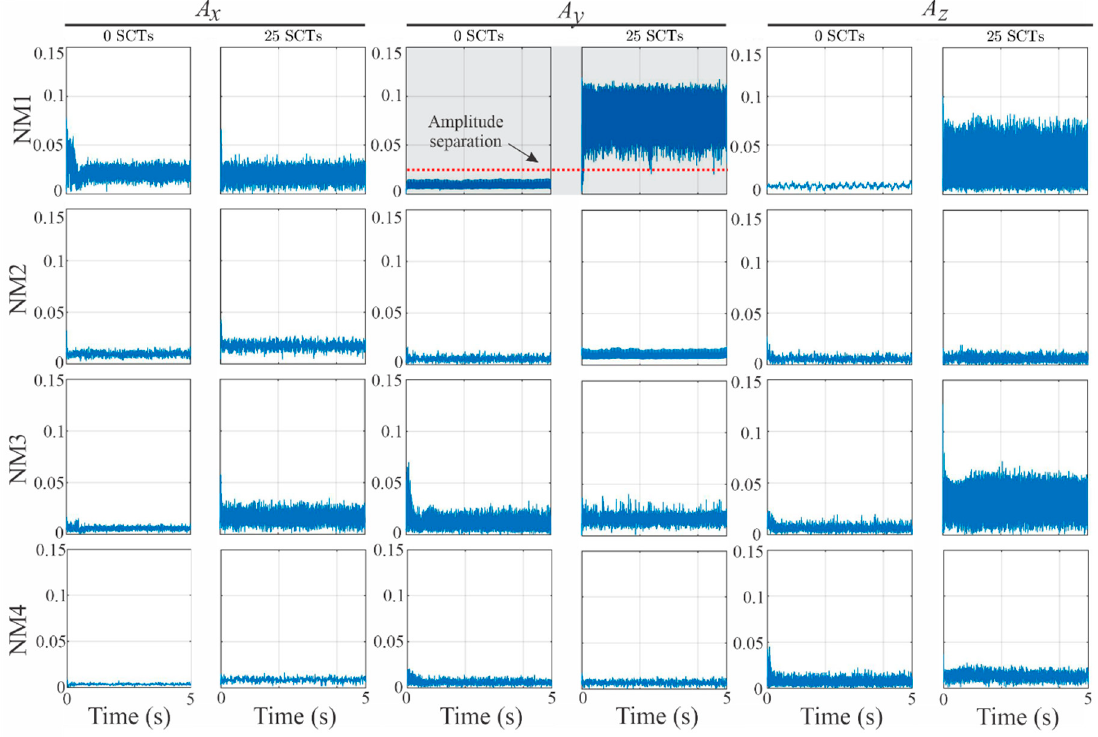
Figure 6. root mean square (RMS) values for the NMs. Figure 6. Root mean square (RMS) values for the